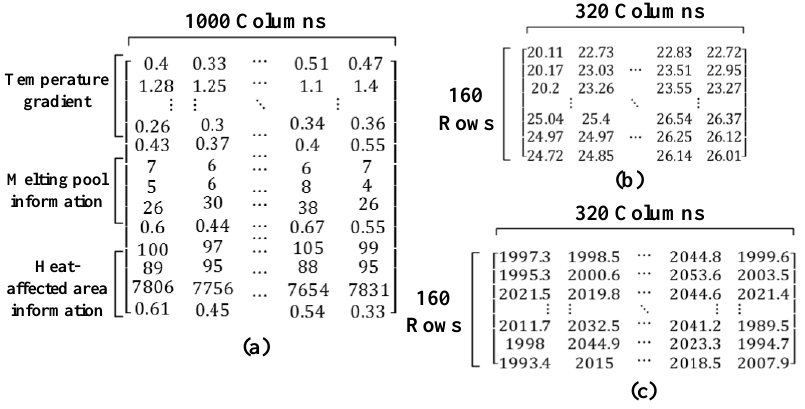
Figure 4. Data Structure of Key Features: ( a ) Extracted information from one temperature image; ( b ) The results of the maximum temperature distribution; ( c ) The result of minimum temperature distribution.